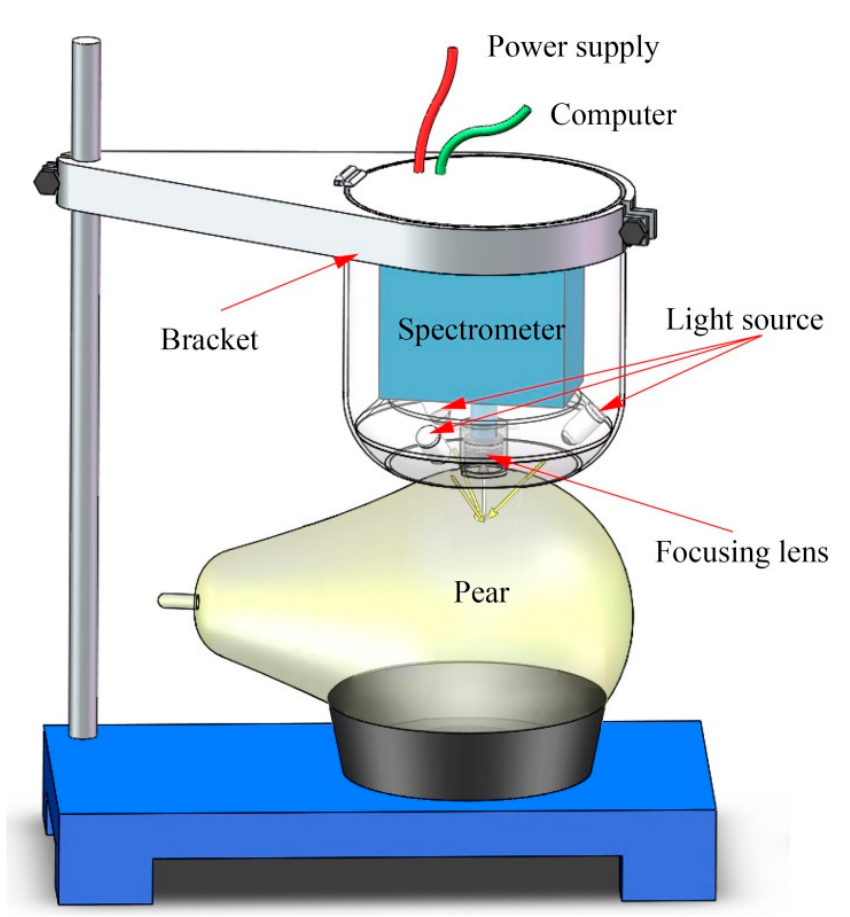
Figure 1. The visible − near-infrared (VIS / NIR) system for spectral measurement.